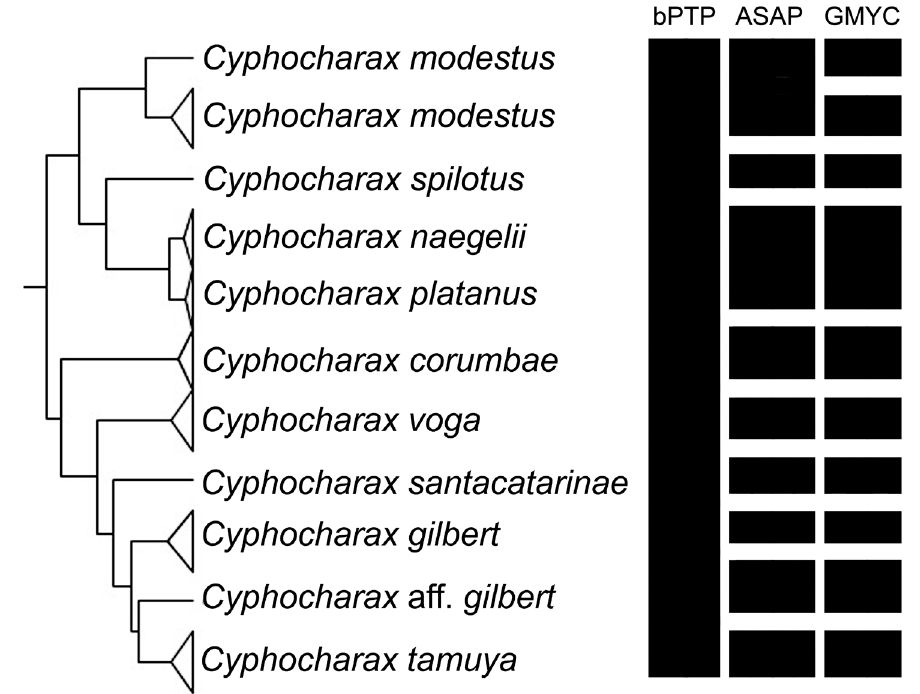
FIGURE 5 | Results of the molecular delimitations methods bPTP, ASAP and GMYC for the species included in the Cyphocharax gilbert clade. MOTUs are represented by black